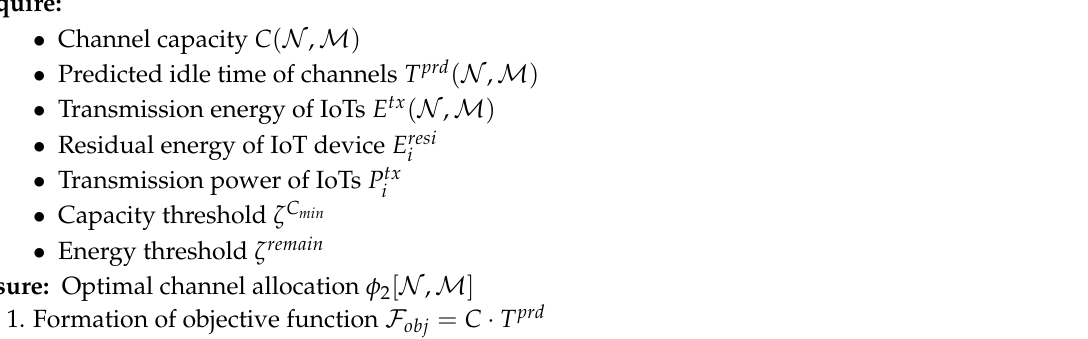
Algorithm 3 Energy and PU activity-aware throughput optimized channel allocation